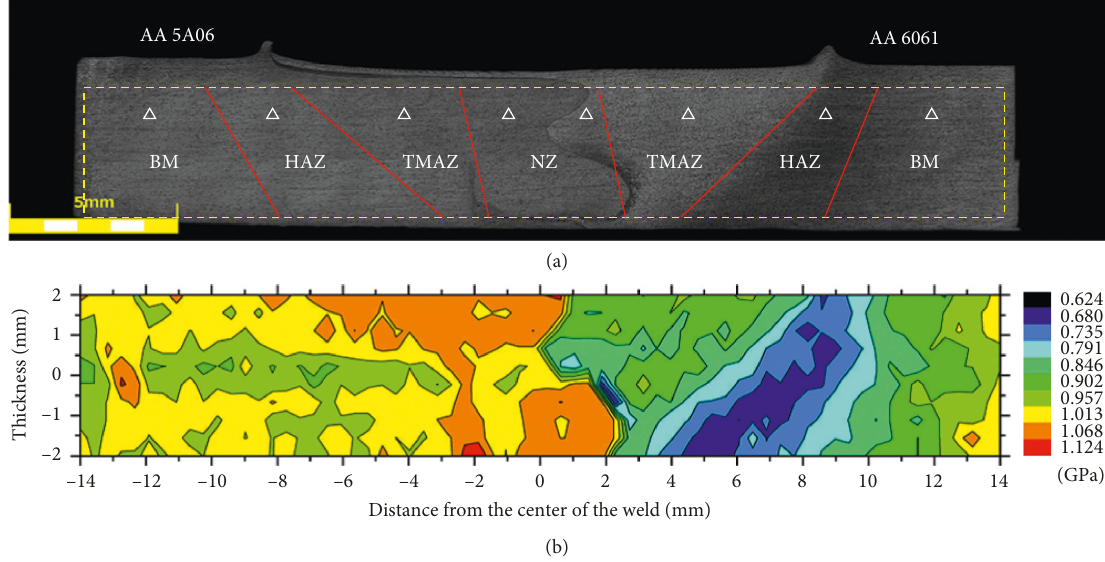
Figure 5: (a) The cross-sectional view of FSW AA 6061-AA 5A06, and (b) nanoindentation hardness distribution on the cross section.